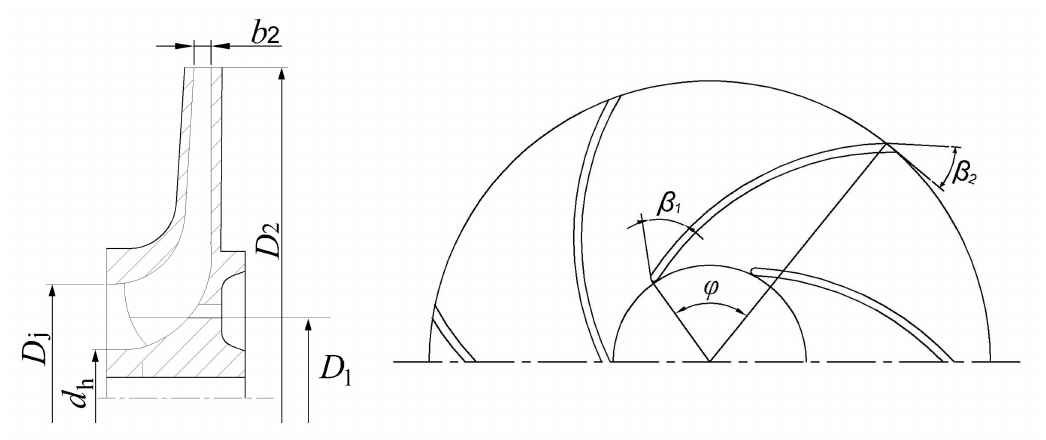
Figure 2. Geometric parameters of centrifugal pump impeller.